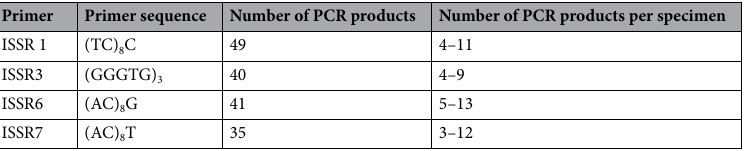
Table 2. The primers used in PCR, primer sequence, total number of reactions products generated by each primer and range fo number of PCR product per specimens.